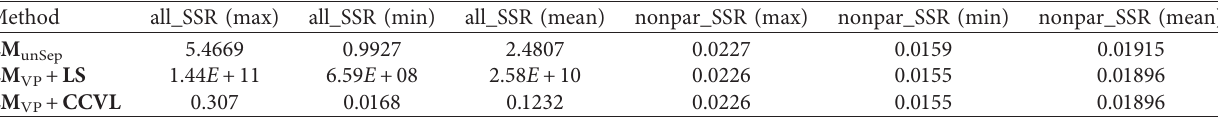
Table 5: Sums of the squared residuals between the estimated parameters obtained using the three methods and the true values in Example 2. Method